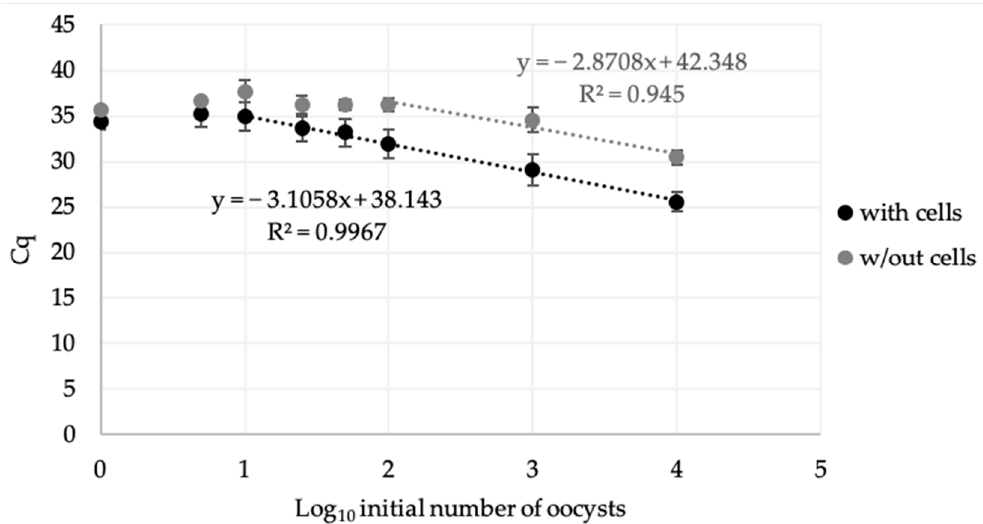
Figure 2. Standard curves of C. parvum DNA resulting from CC–qPCR after inoculation of purified oocysts onto wells with (black) or without (grey) HCT-8 cells. Table 2. CC–qPCR assay results for C. parvum oocysts recovered from lamb’s lettuce. Number of Inoculated Oocysts Per 30 g of Lamb’s Lettuce